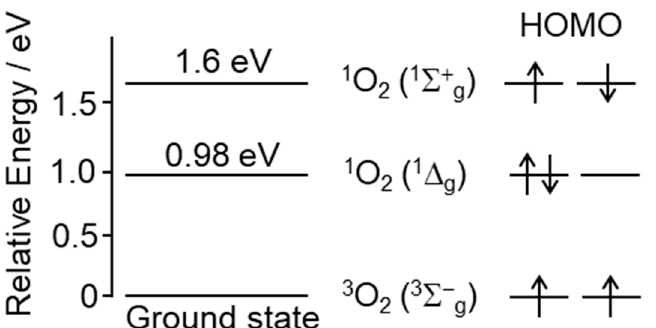
Figure 1. Relationship between energy levels of ground state triplet oxygen molecule 3 O 2 and singlet oxygen molecule 1 O 2 . The ground state oxygen molecule, triplet oxygen 3 O 2 ( 1 Σ − g ), has two unpaired and spin-parallel electrons in π * antibonding orbitals. 3 O 2 ( 3 Σ − g ) in the ground state receives energy and is excited to the singlet state, forming singlet oxygen ( 1 O 2 ). 1 O 2 is the spin-flipped electron state of 3 O 2 ( 3 Σ − g ). There are two states of 1 O 2 : 1 O 2 ( 1 Σ +g ) and 1 O 2 ( 1 Δ g ). 1 O 2 ( 1 Σ +g ) and 1 O 2 ( 1 Δ g ) have energies that are 1.6 eV and 0.98 eV higher than the ground state 3 O 2 ( 3 Σ − g ), respectively. The lifetime of 1 O 2 ( 1 Σ +g ) is a few picoseconds, and it is rapidly converted to 1 O 2 ( 1 Δ g ). Since the lifetime of 1 O 2 ( 1 Δ g ) is several microseconds, which is significantly longer than that of 1 O 2 ( 1 Σ +g ), the 1 O 2 generated in vivo can be 1 O 2 ( 1 Δ g ). The arrows indicate the direction of the electron spin of the highest occupied molecular orbital (HOMO).